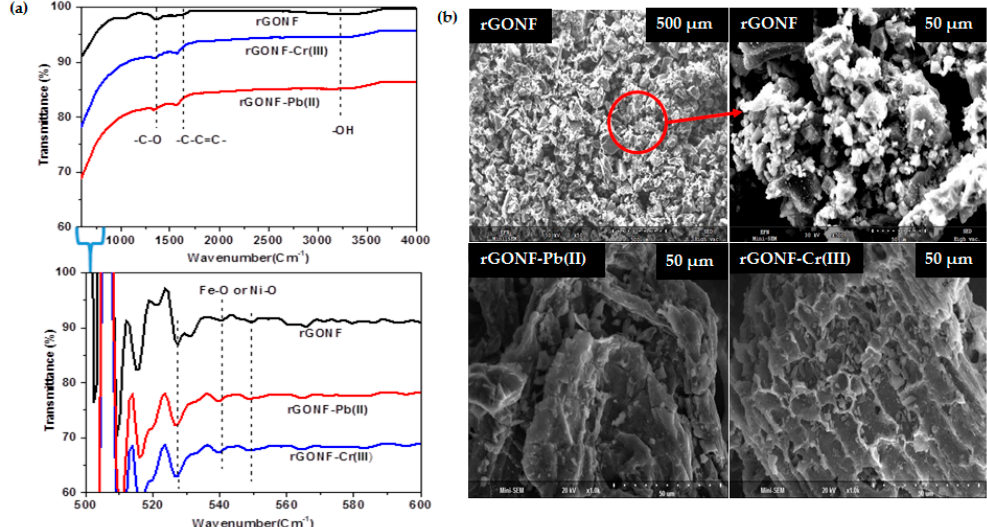
Figure 4. Fourier Transfer-Infrared Resonance (FT-IR) spectra of rGONF ( a ) and scanning electron microscopy images of rGONF and metal ion loaded rGONF ( b ). (The dotted lines indicate the functional groups and its comparative shifting of peaks by loading; the scale bare in the Figure 4b is 50 to 500 μ m and the high-resolution of red circled in Figure 4b indicates the highly porous nature of rGONF). Metals 2017 , 7 , 225